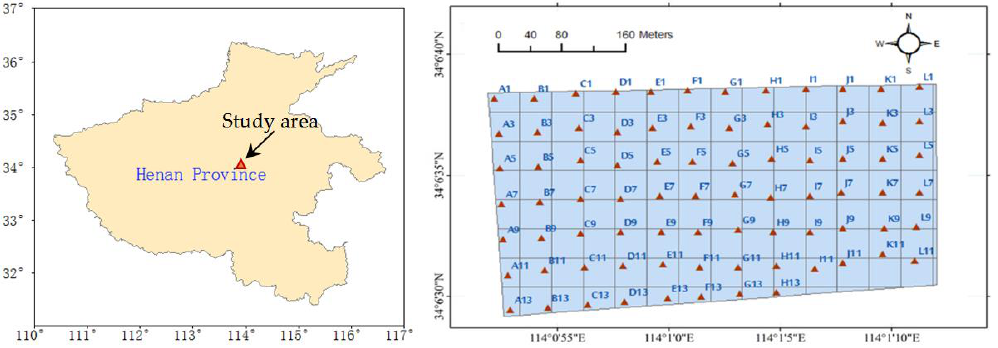
Figure 1. Distribution of soil sampling points.